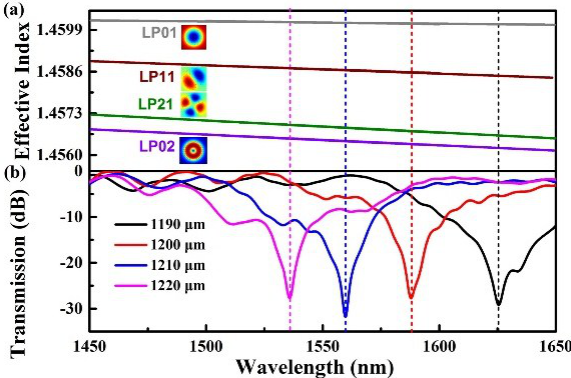
Figure 3. ( a ) Calculated effective refractive indices plotted as a function of wavelength for the LP 01 , LP 11 , LP 21 , and LP 02 modes; ( b ) The transmission spectra of four CO 2 -laser-induced LPFGs with grating pitches of 1190, 1200, 1210, and 1220 μm.